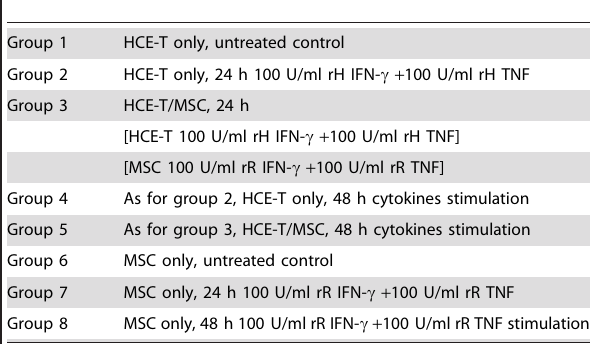
Table 3. Groups for detection of TGF- b 1 secretion.